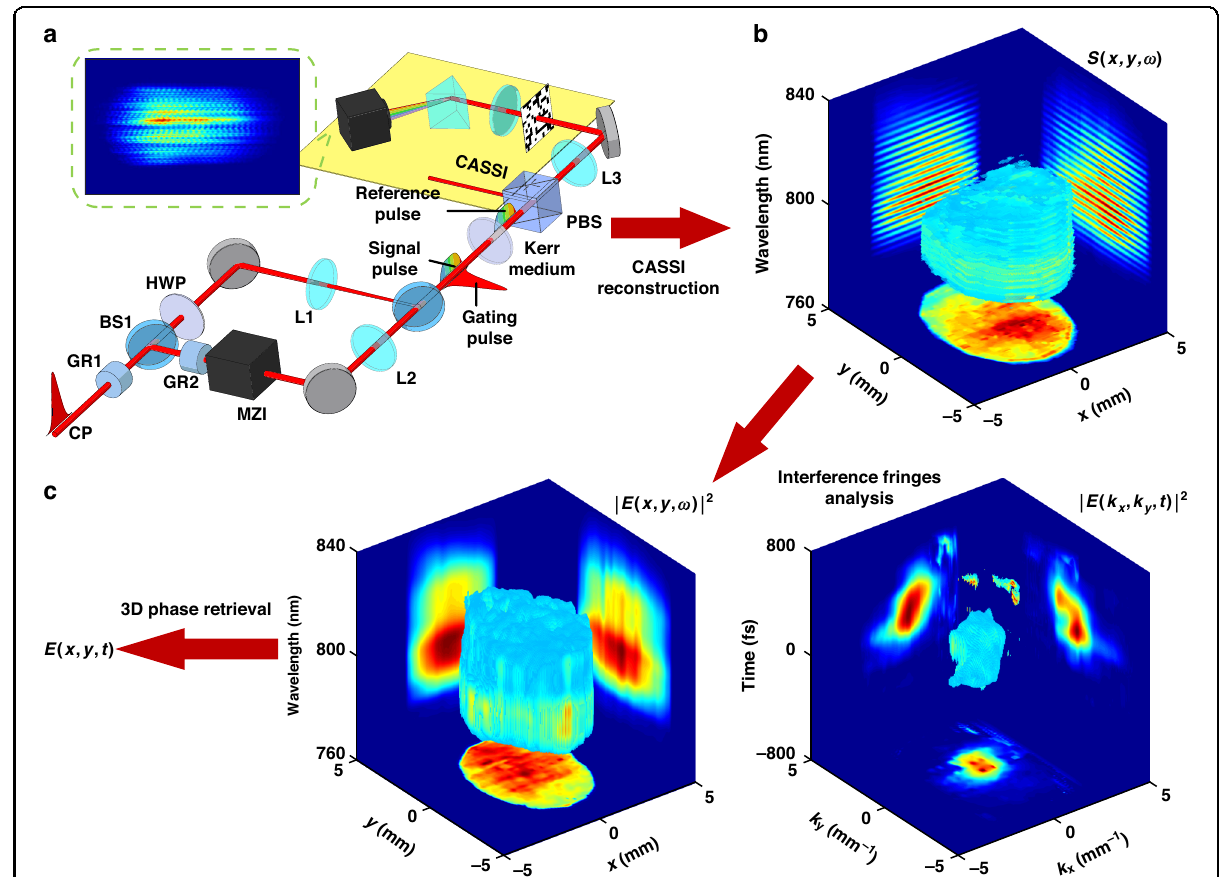
Fig. 4 Principle of COFT based on 3D spectral holography. a The experimental setup. The incident optical fi eld at CP, the checking point, is pre- chirped by an SF11 glass rod (GR1) and split by beam splitter BS1. The transmitted gating pulse is focused by the lens L1 to a thin glass plate as the Kerr medium. The re fl ected pulse is further chirped by an SF11 glass rod (GR2) and manipulated by a Mach-Zehnder interferometer (MZI) to generate a time-delayed reference-signal pulse pair. The reference-signal pulses are imaged by lens L2 to the Kerr medium, and the signal pulse picks up phase shift induced by the gating in the Kerr medium. After the cross-polarized gating pulse is fi ltered out by a polarization beam splitter (PBS), the remaining reference and signal pulses interfere and generate a 3D spectral hologram, which is imaged by lens L3 to the coded aperture of a CASSI system. Raw data is shown in the inset. b CASSI reconstruction of the 3D spectral hologram S x ; y ; ω ð Þ due to interference between the reference and (cid:4) (cid:1) (cid:3)(cid:4) (cid:4) (cid:4) 2 and E x ; y ; ω ð Þj j 2 3D intensity pro fi les of the incident optical fi eld. The former is the modulated signal probe. c The E k x ; k y ; t